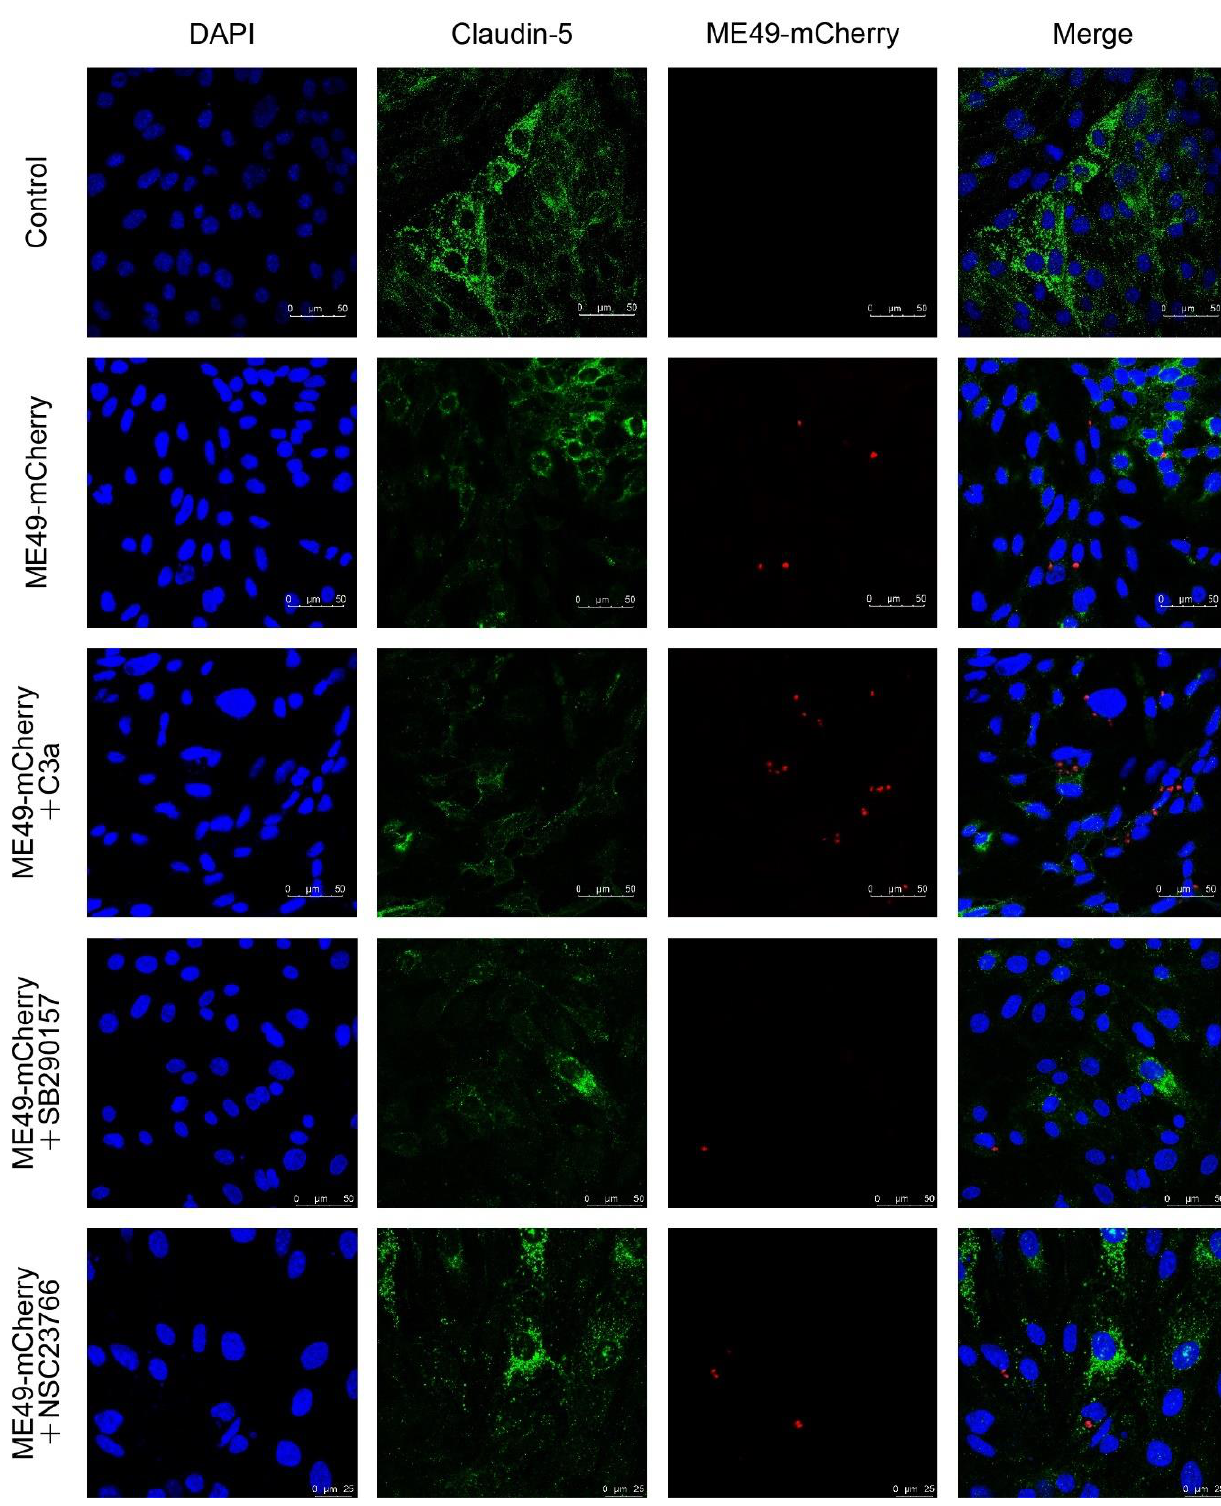
Figure 3. SB290157 and NSC23766 restrained Claudin-5 expression and inhibited T. gondii entering into bEnd3 cells. Representative images of Claudin-5 and ME49-mCherry immunofluorescence staining (200×). Blue, DAPI staining of DNA; Green, Claudin-5; Red, ME49-mCherry. 2.5. Anxa1 Was Picked out as a Protein Which Could Directly Act on C3a